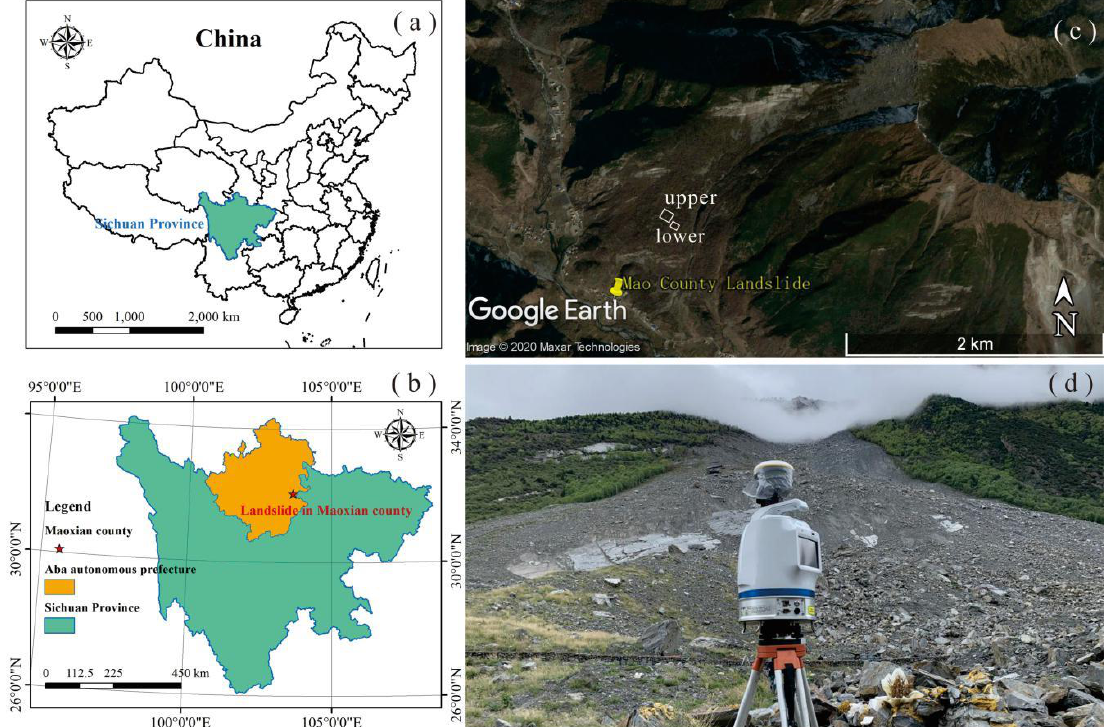
Figure 3. Location of Mao County landslide ( a , b ) and scanning regions in the accumulation ( c ). Field configuration of the Optech Polaris LR laser scanner used to collect the dense point cloud of landslide deposit ( d ).